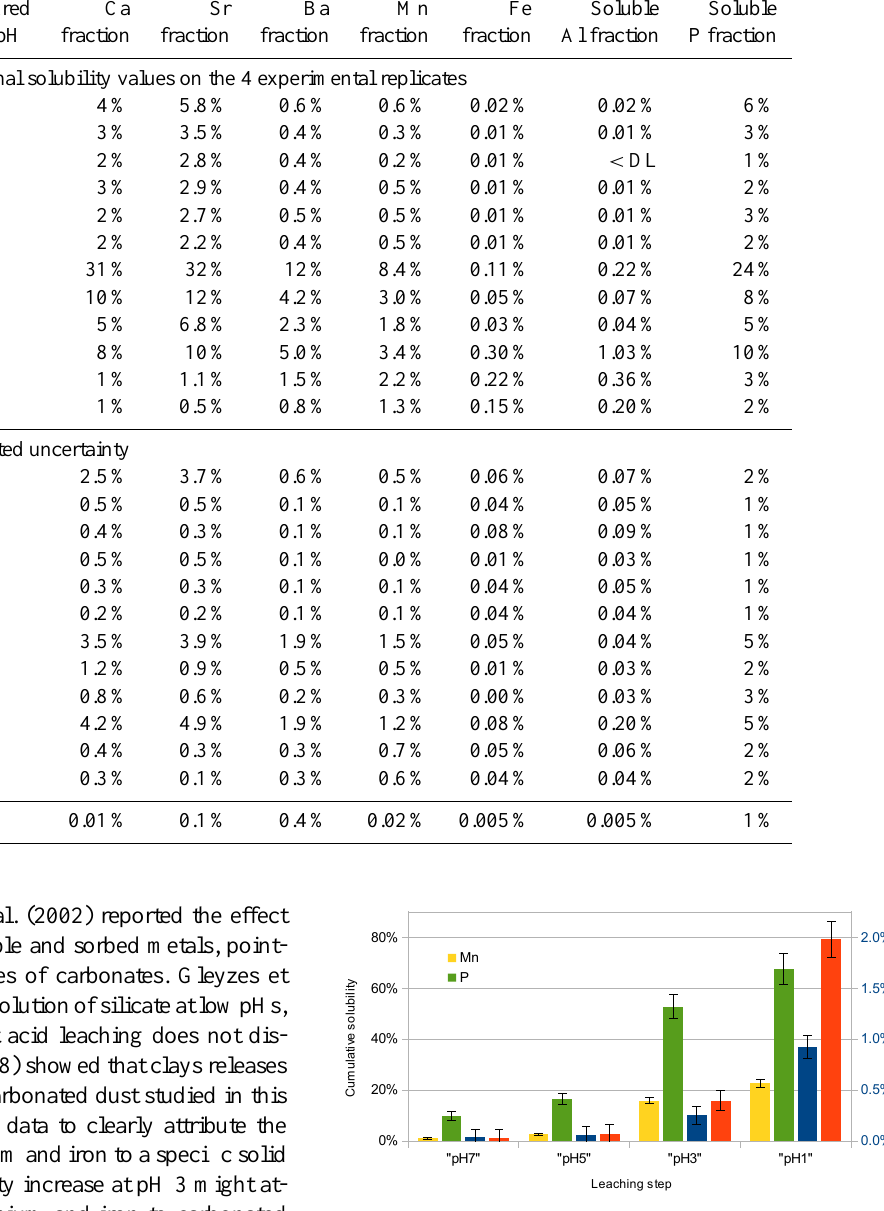
Figure 3. Cumulative solubility for Mn, P (left scale), Fe, and Al (right scale). The vertical segments are the standard deviation of the four replicates.